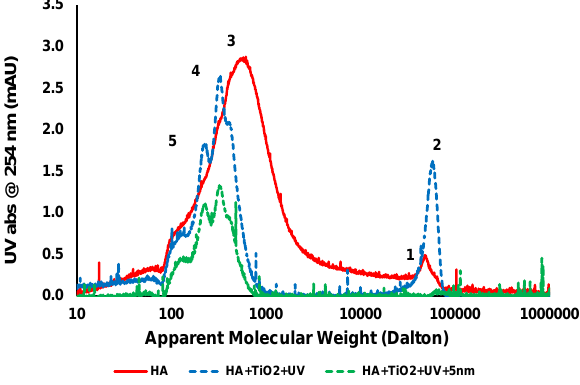
Figure 6. LC analysis of HA at different stages of treatment (HA concentration: 20 mg/L, TiO 2 concentration: 0.5 g/L, TMP: 100kPa, pH: 7.5; UV intensity: 3.4 mW/cm 2 ).